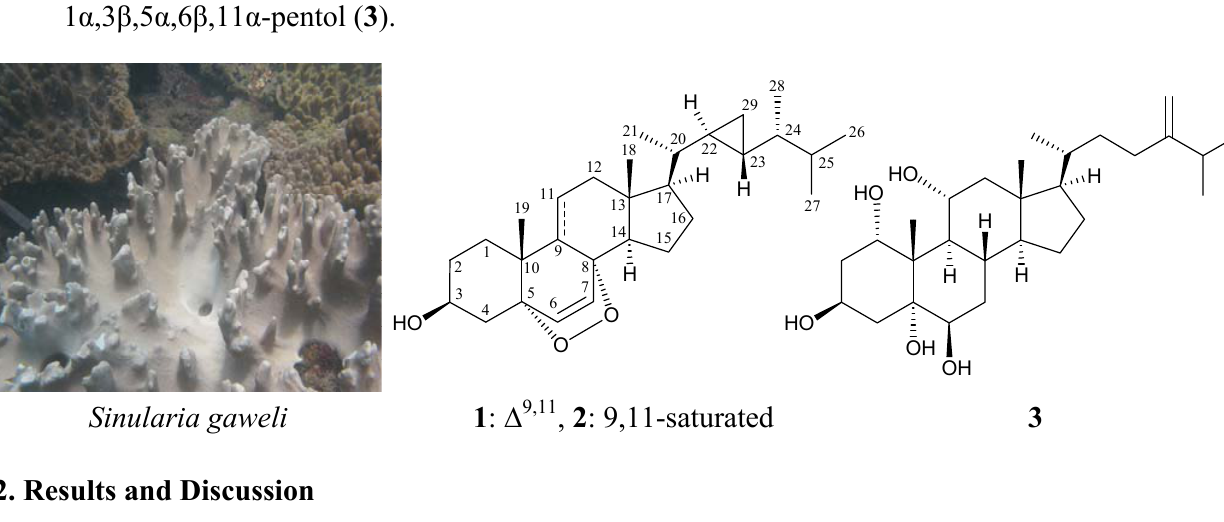
Figure 1. The soft coral Sinularia gaweli and the structures of (22 R ,23 R ,24 R )-5 α ,8 α - epidioxy-22,23-methylene-24-methylcholest-6,9(11)-dien-3 β -ol ( 1 ), (22 R ,23 R ,24 R )-5 α ,8 α - epidioxy-22,23-methylene-24-methylcholest-6-en-3 β -ol ( 2 ) and 24-methylenecholestane- 1 α ,3 β ,5 α ,6 β ,11 α -pentol ( 3